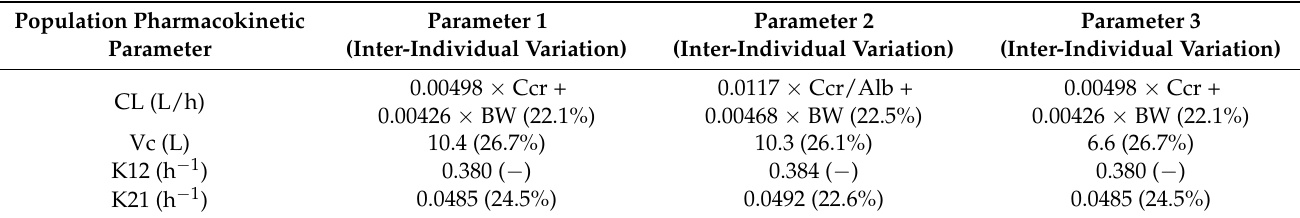
Table 1. Population pharmacokinetic parameters used for the teicoplanin dosage